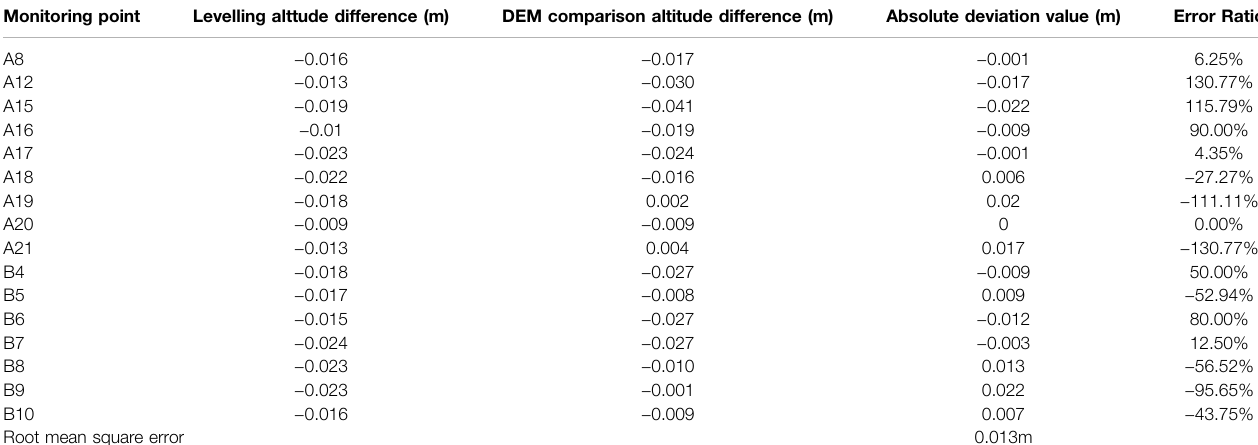
TABLE 3 | The speci fi c point accuracy of initial results. Monitoring point